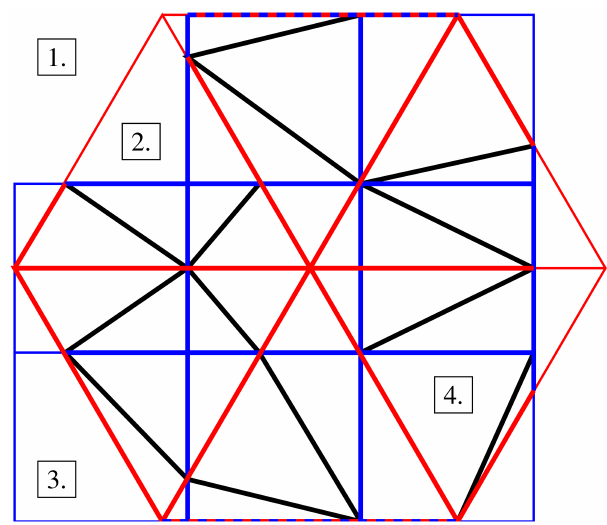
Figure 5. Exemplary 2D exchange grid formed by a triangular at- mosphere (red) and a rectangular ocean (blue) grid. The exchange grid consists of edges from the original triangular and rectangular grids (thick red and blue) and additional edges from the triangu- lation (black). Assuming that only water cells are shown, the four possible combinations of land/ocean masks are labelled. Here the exchange grid is shown for the interpolation from the ocean to the atmosphere grid, therefore, excluding the elements of case